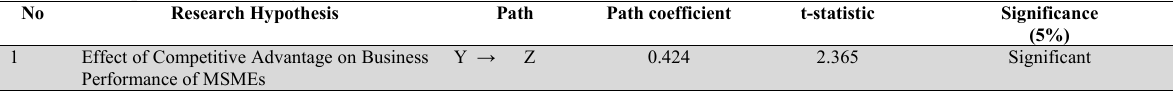
Effect of Competitive Advantage on Business Performance of MSMEs in Jambi Province Research Hypothesis